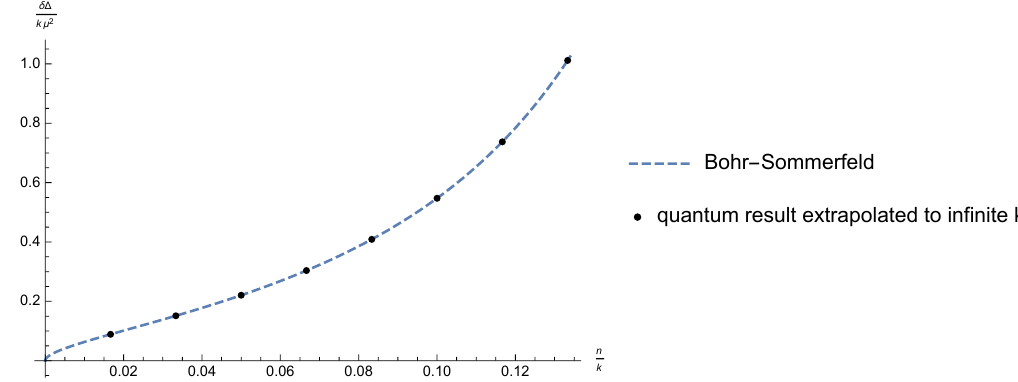
Figure 2 . RR correction to the spacetime energy δ ∆ in units of kµ 2 , numerically extrapolated to infinite level k at fixed n (black dots), compared to the semiclassical result (4.27) (dashed k blue